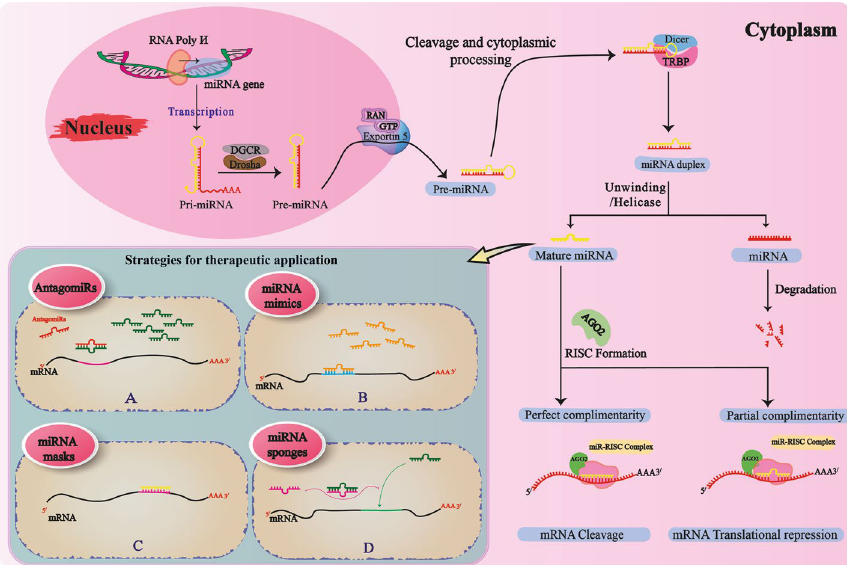
Fig. 1 Processing of miRNAs, from biogenesis to therapeutic strategies. miRNAs are transcribed from particular genes inside the nucleus through the action of RNA polymerase II. After the formation of pri-miRNA, this is developed to pre-miRNA by the Drosha–DGCR complex. Then, the pre-miRNA leaves the nucleus for the cytoplasm via exportin 5. Following particular cytoplasmic processing and the action of the Dicer–TRBP complex, pre-miRNA is converted into duplex miRNA, which then undergoes an unwinding to produce mature miRNA. Mature miRNA, using the Ago-2 protein, forms a complex with RISC to cleave the mRNA of interest, or suppresses the translation process. In the case of therapeutic strategies attributed to miRNAs, there are four distinct strategies: A AntagomiRs that bind to and inhibit the action of oncomiRs by blocking miRNA-to-mRNA attachment, through a process called antisense action. AntagomiRs are also responsible for further degradation of miRNAs; B miRNA mimics , which help anticarcinogenic miRNAs to induce tumor-suppressive activities by reversing the epigenetic silencing; C miRNA masks that prevent miRNAs from acting on mRNAs by masking the 3 ′ -UTR sequence on the mRNA strand; D miRNA sponges , whose behavior prevents miRNAs from acting on mRNAs by occupying the binding sites of a particular miRNA or even a set of miRNAs with similar seed sequences by a complementary RNA